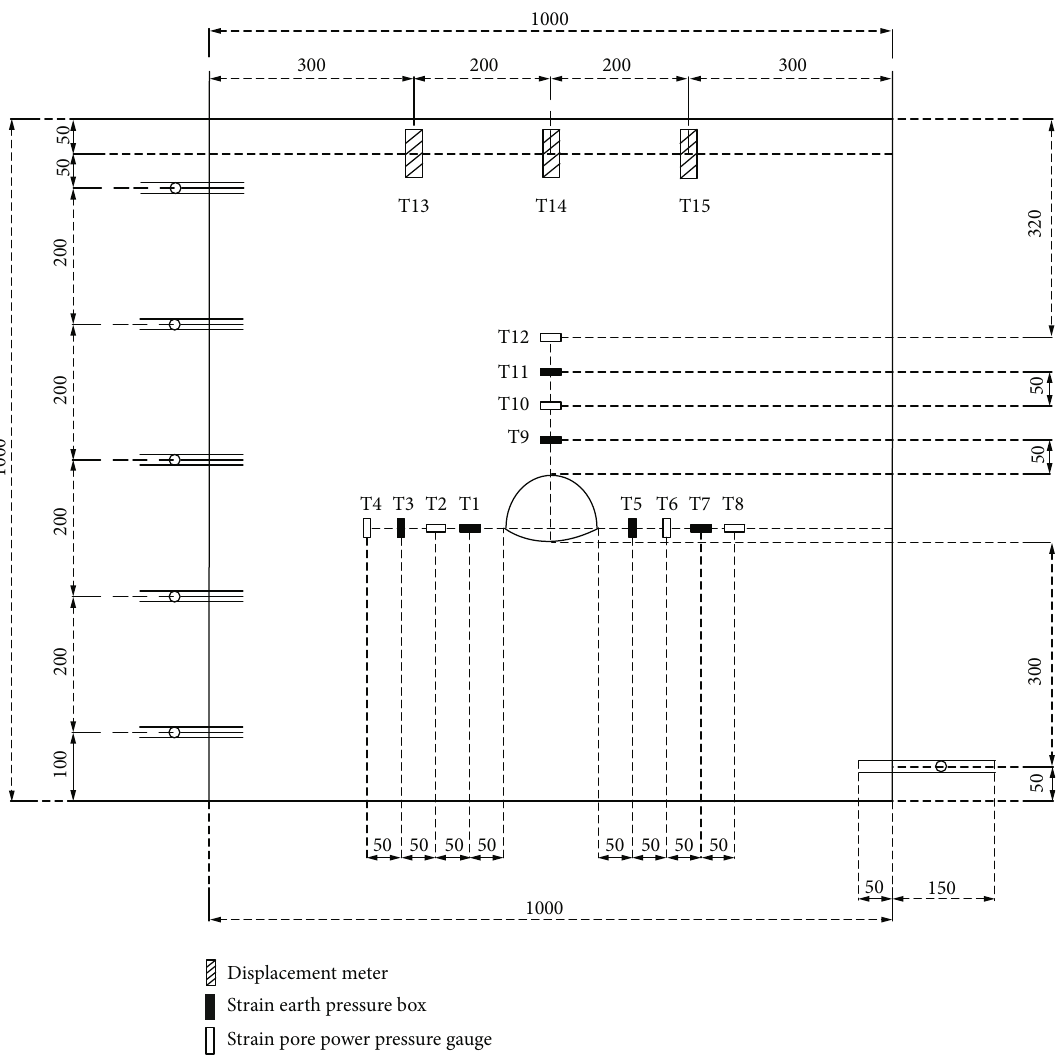
Figure 2: Schematic of measuring points